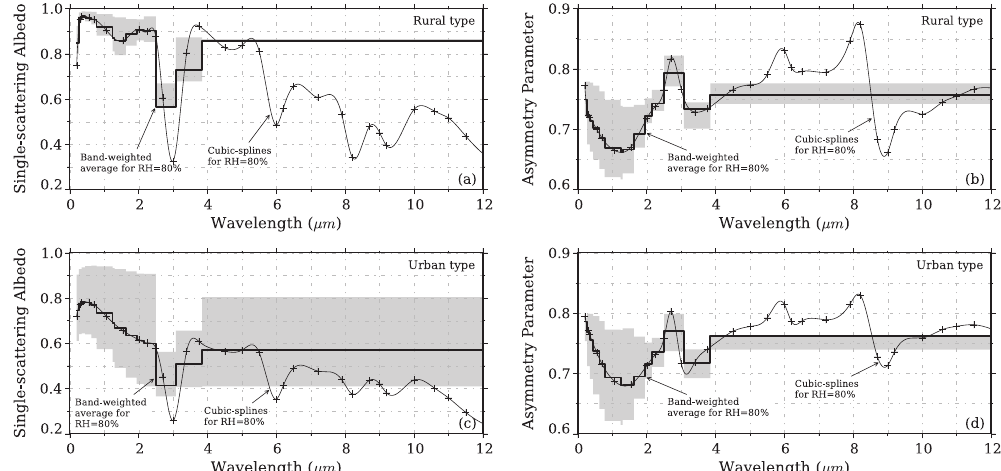
Figure 2. Parameterized SSA and ASY parameters for the rural and urban aerosol mixtures and a relative humidity of 80% (thick line). The Shettle and Fenn (1979) spectral values are shown with cross marks. They are interpolated using cubic splines (thin line). The grey region encompasses the variability range of the parameters with different values of relative